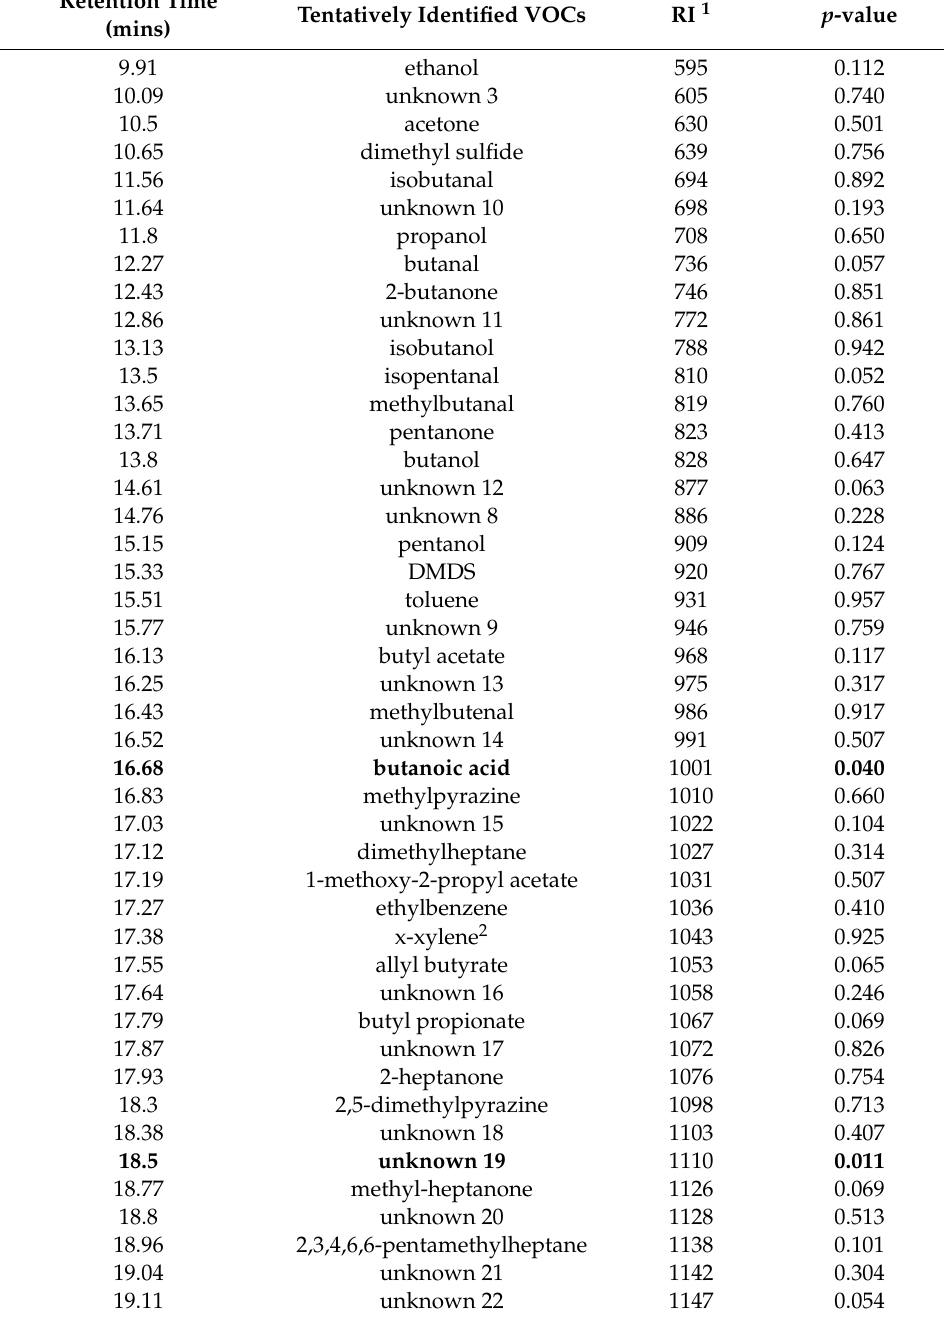
Table 2. List of tentatively identified VOCs detected in 84 samples of bacterial